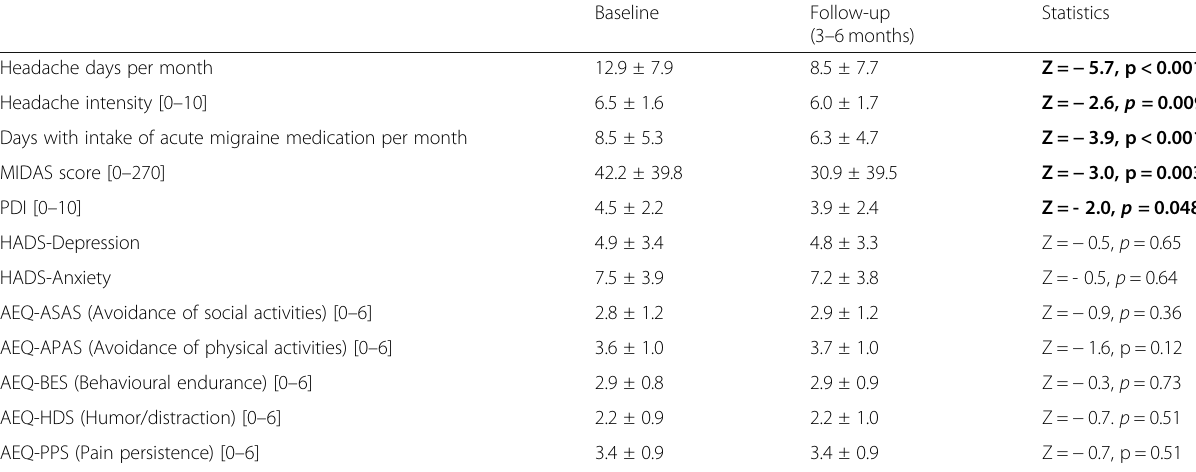
Table 4 Change in headache outcomes and behavioural parameters at follow-up (3 – 6 months, n = 66 –